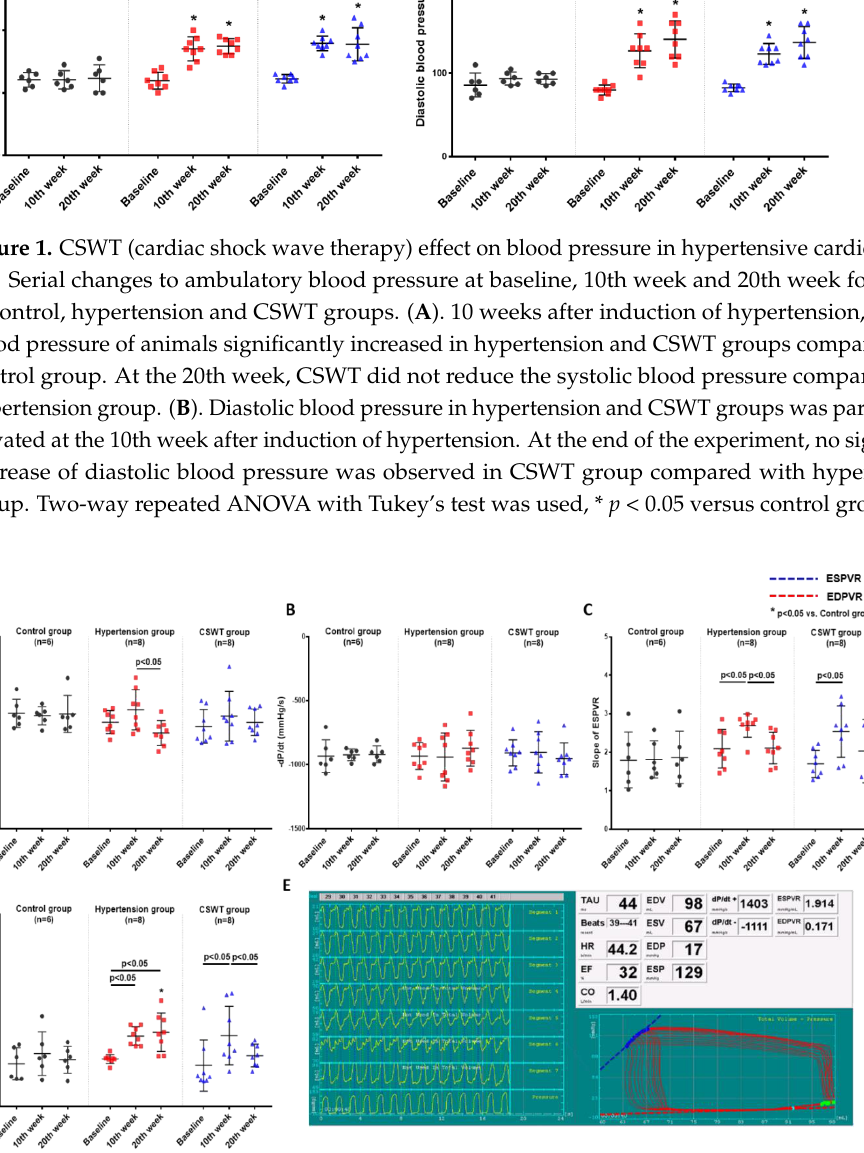
Figure 2. CSWT effect on hemodynamic parameters. Hemodynamic parameters at baseline, 10th week and 20th week follow − up in control, hypertension and CSWT groups. ( A ) . No significant difference of +dP/dt was observed in hypertension and CSWT groups at the 10th week compared with control group and at baseline. At the 20th week, +dP/dt decreased significantly in hypertension group compared with the 10th week. ( B ) . No significant difference of − dP/dt among the three groups throughout whole experiment. ( C ) . At the 10th week in hypertension and CSWT groups, ESPVR (end − systolic pressure − volume relationship) increased compared with baseline. At the 20th week, there was significant decrease of ESPVR in hypertension group but not in CSWT group compared with the 10th week. ( D ) . 10 weeks after induction of hypertension, EDPVR (end − diastolic pressure − volume relationship) increased significantly in hypertension and CSWT groups compared with baseline. At the 20th week, CSWT significantly reduced EDPVR in CSWT group compared with the 10th week. ( E ) . Representative tracing of the left ventricular pressure volume loop. Two −way repeated ANOVA with Tukey’s test was used, * p < 0.05 versus control group.